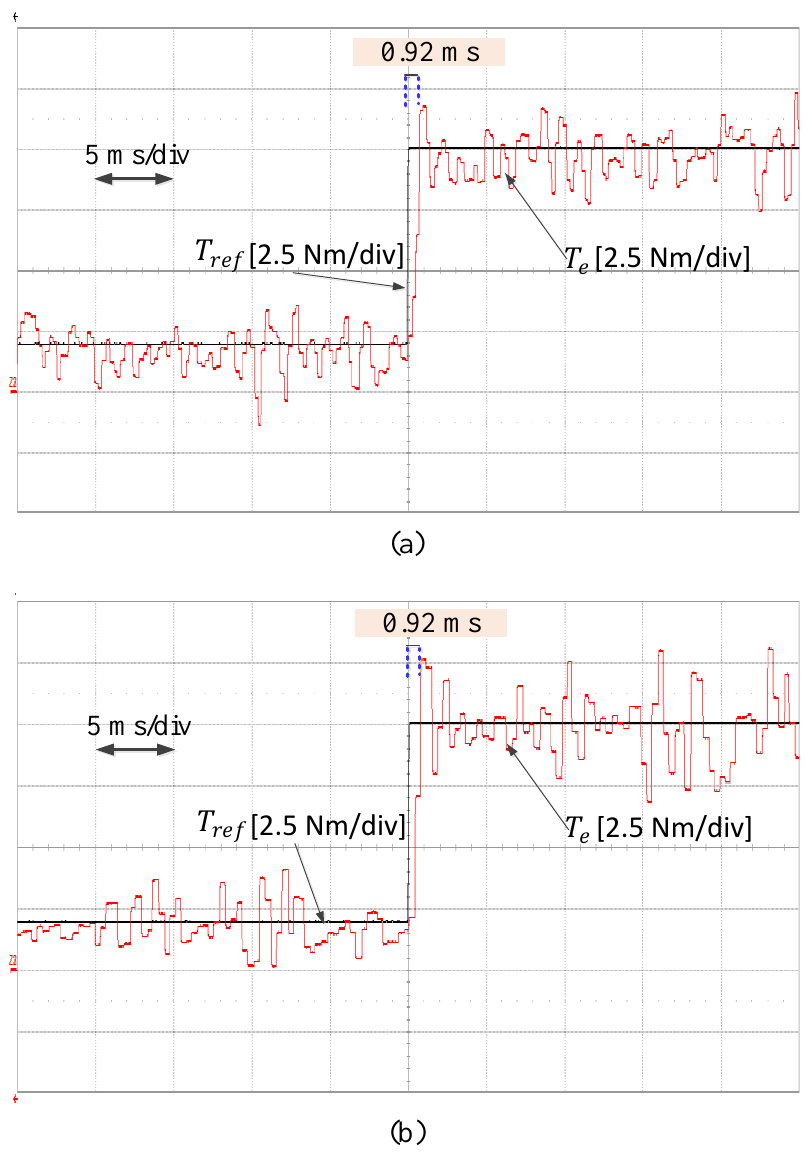
Figure 12. Experimental dynamic torque response from 2 to 10 Nm at 600 rpm for ( a ) UFCS-PTC and ( b ) MMPTC. Table 5. Quantitative comparison for UFCS-PTC and